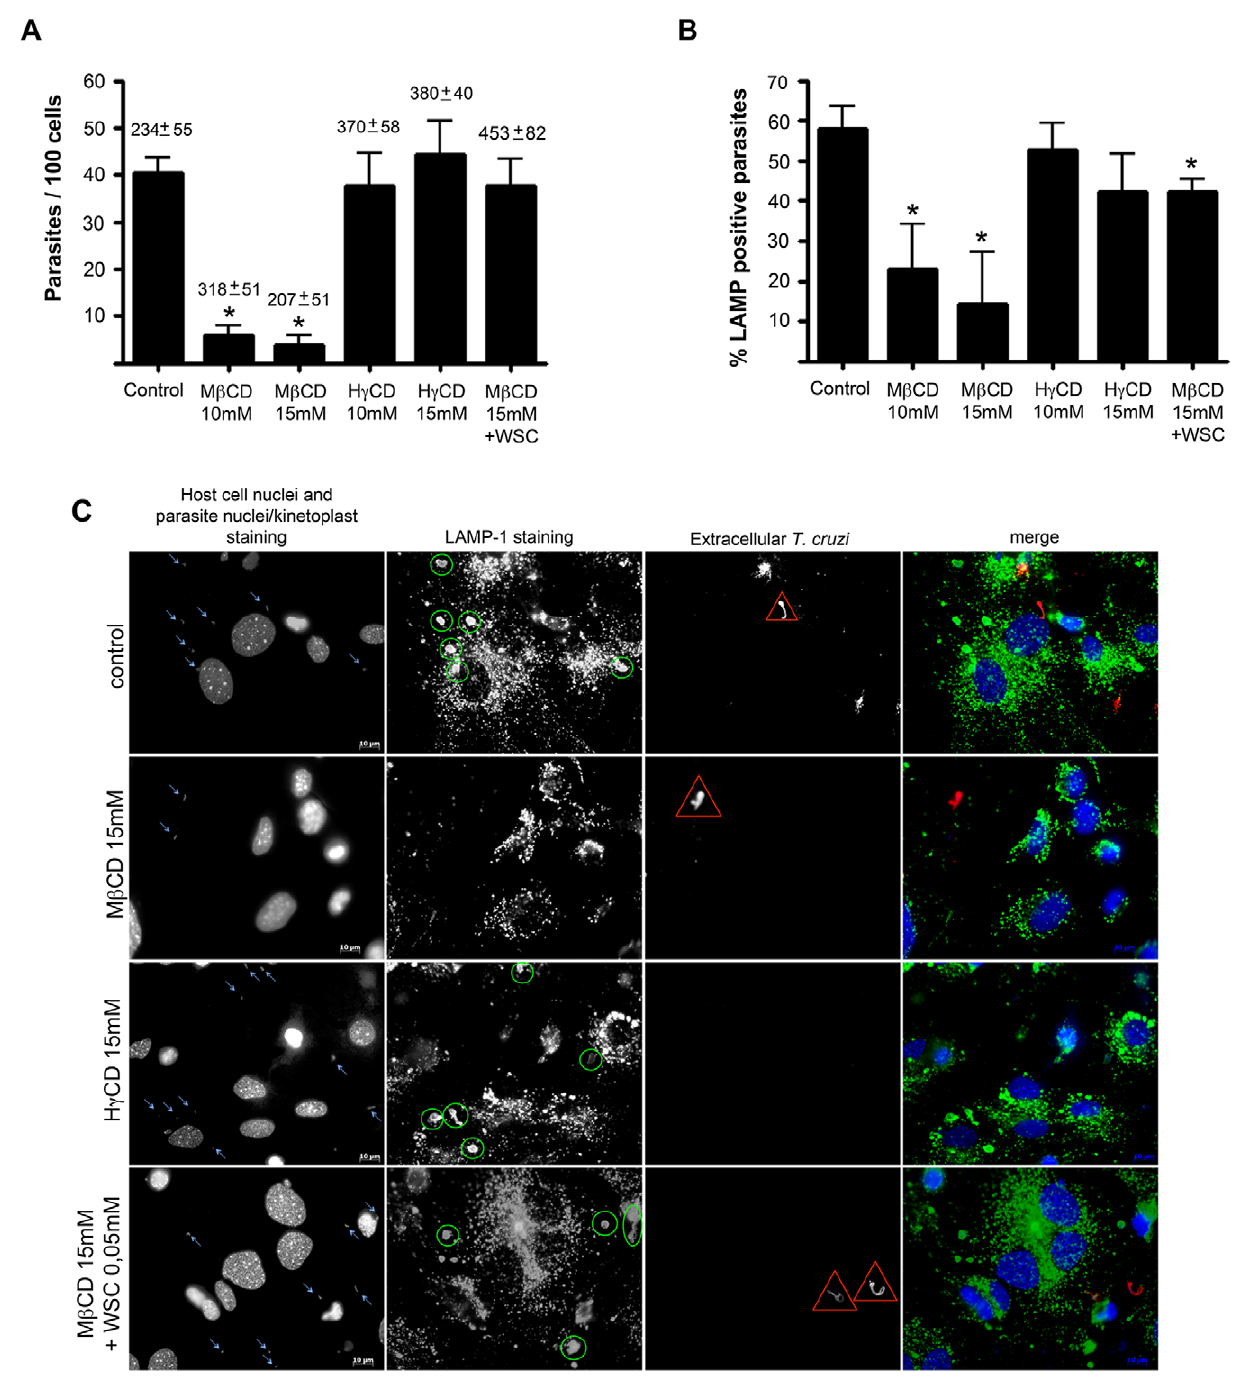
Figure 2. T. cruzi invasion of cells and association with LAMP-1 in cardiomyocytes decreases after cholesterol depletion. Cardiomyocytes pre-treated or not with different cyclodextrins were washed and challenged with T. cruzi trypomastigotes at a M.O.I of 50, for 40 minutes at 37 u C, then fixed and processed for immunofluorescence detection of total intracellular parasites, as well as intracellular parasites associated with LAMP-1 (a lysosomal marker). Both T. cruzi internalization (A) and association with host LAMP-1 (B) diminishes after incubation with 10 and 15 mM of M b CD but not after treatment with 10 and 15 mM of H c CD. Cholesterol replenishment after treatment with 15 mM M b CD reverts the effect of the drug on parasite cell invasion (A), and at least partially on LAMP-1 association (B). The average number of cardiomyocytes 6 SD per 10 counted fields in each coverslip is shown above the bars (A). Data are shown as mean of triplicates 6 SD. Asteriks indicate statistically significant differences (p , 0.05, Student’s t test) between control and treated cells. (C) Representative panels of T. cruzi invasion and association with host cell lysosomes, revealed by immunocytochemistry. Total cell and parasite nuclei, as well as parasite kinteoplast DNA were labeled with DAPI; lysosomes were labeled with anti-LAMP 1 antibody followed by secondary IgG labeled with Alexa Fluor 488; extracellular parasites in the field were labeled with anti- T.cruzi antibody followed by secondary IgG labeled with Alexa Fluor 546. From top to bottom: control cells, 15 mM M b CD treated cells, 15 mM H c CD treated cells and 15 mM M b CD treated cells followed by incubation with 0.05 mM of WSC. Blue arrows show total T. cruzi trypomastigotes in